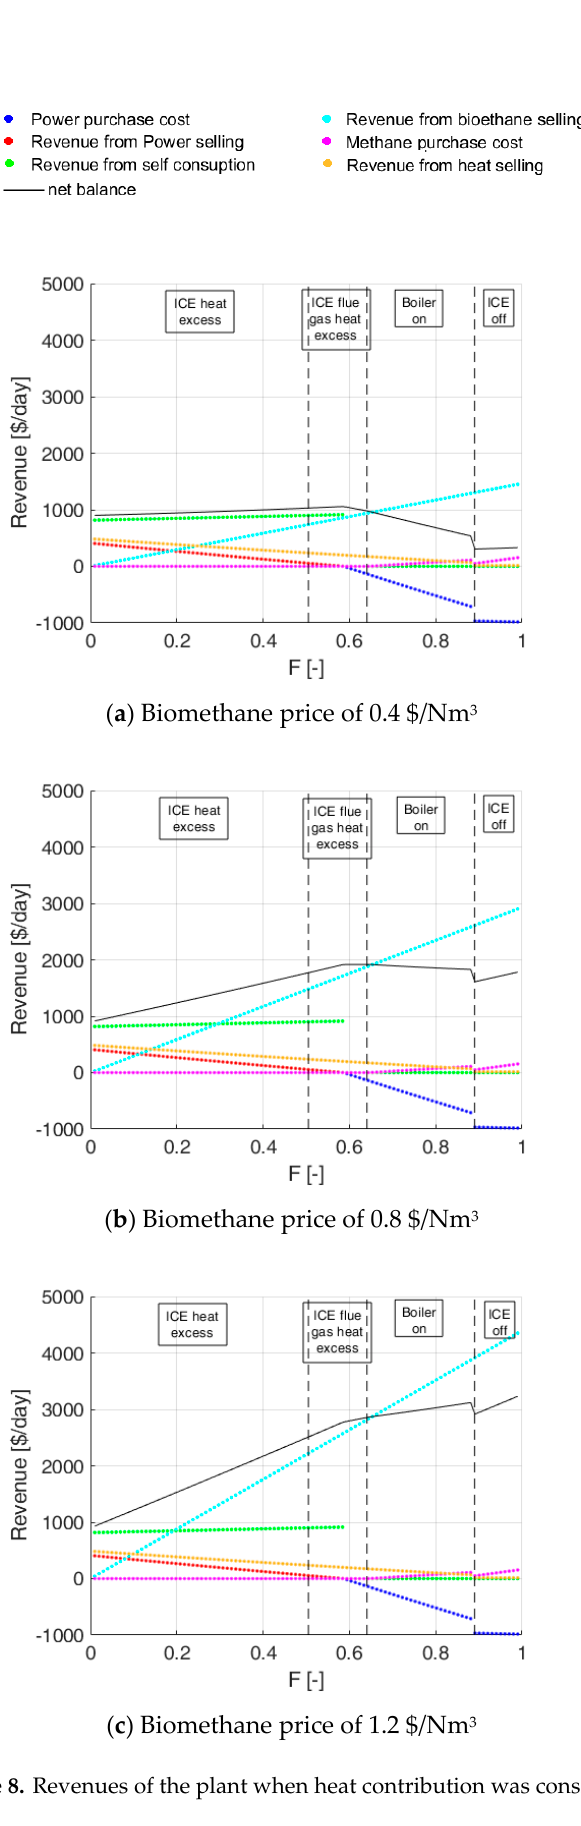
Figure 8. Revenues of the plant when heat contribution was